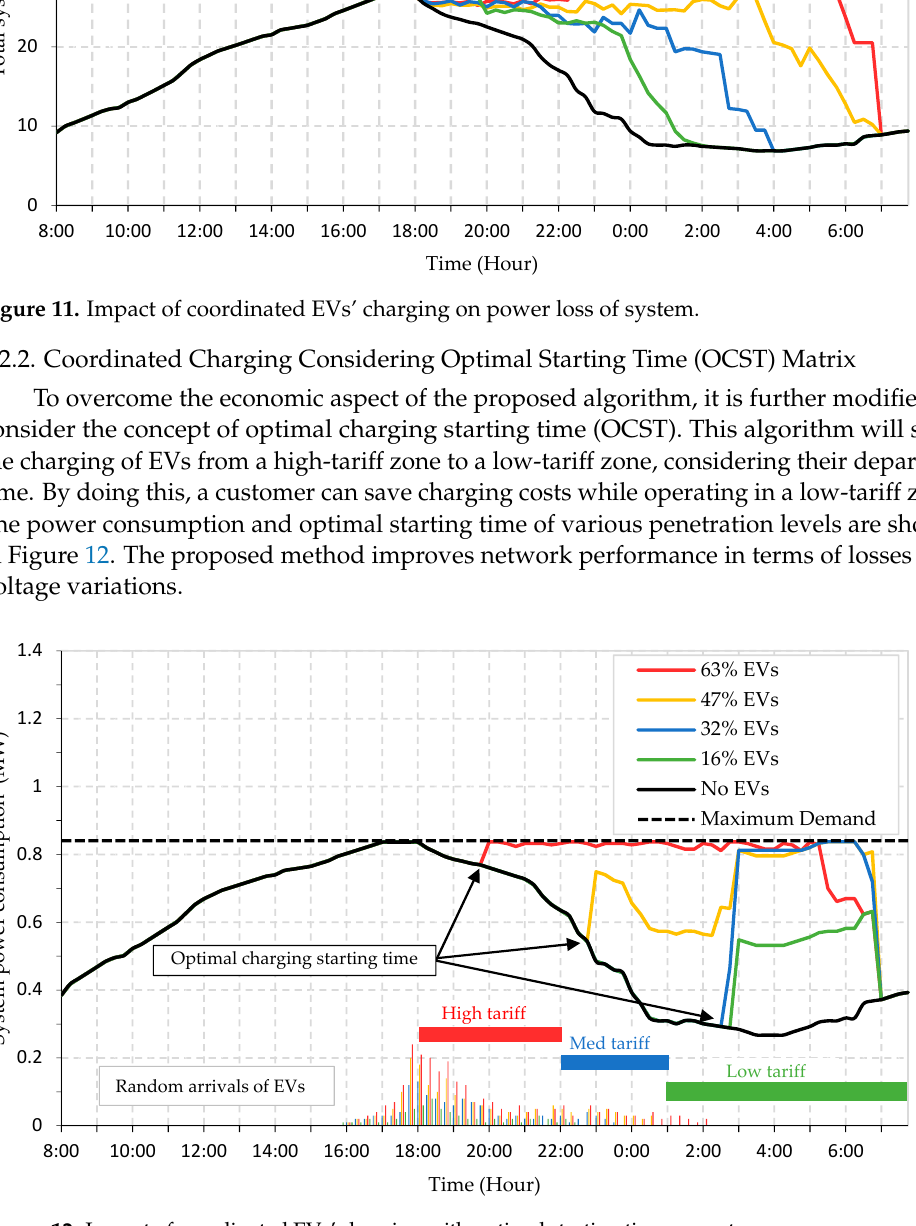
Figure 12. Impact of coordinated EVs’ charging with optimal starting time on system power consumption.